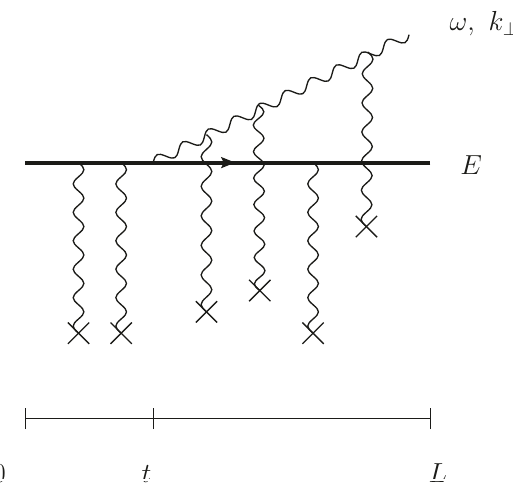
Figure 1 . Diagrammatic representation of a high energy quark radiating a soft gluon induced by coherent multiple scattering in a medium of length L